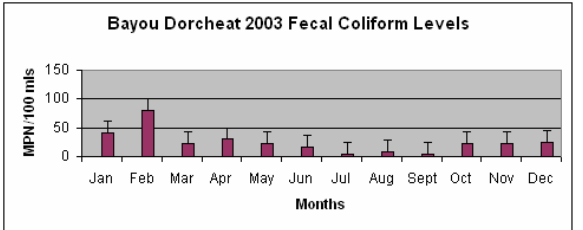
Figure 4: Bayou Dorcheat Fecal Coliform Levels (MPN/100 mls) for